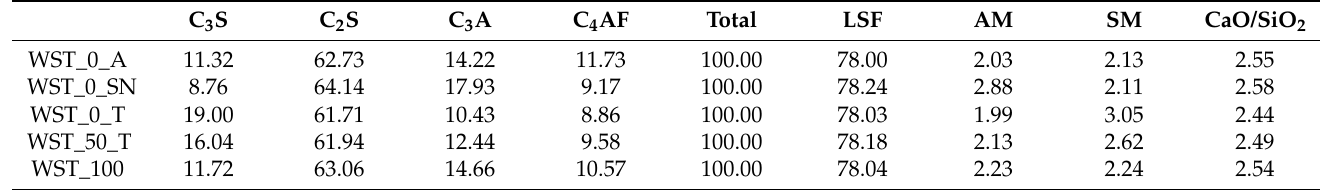
Table 8. Composition of target phases (wt %), quality indexes (LSF, AM, and SM), and weight ratio (CaO/SiO 2 ) of the crude blends designed in this